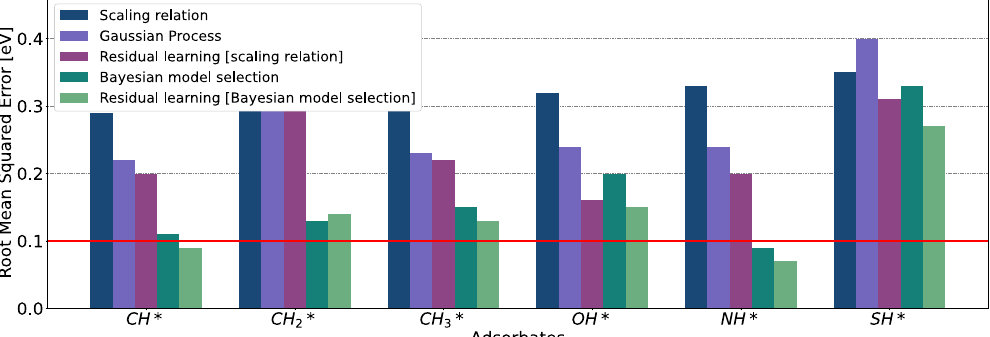
Fig. 7 Root mean squared error (RMSE) in eV for the holdout test set for different methods. RMSE for scaling relations, Gaussian process regression, residual learning with scaling relation as the baseline model, Bayesian model selection, and residual learning with Bayesian model selection as the baseline model, respectively. We add a horizontal guiding line at 0.1 eV to show the error with respect to the commonly accepted DFT